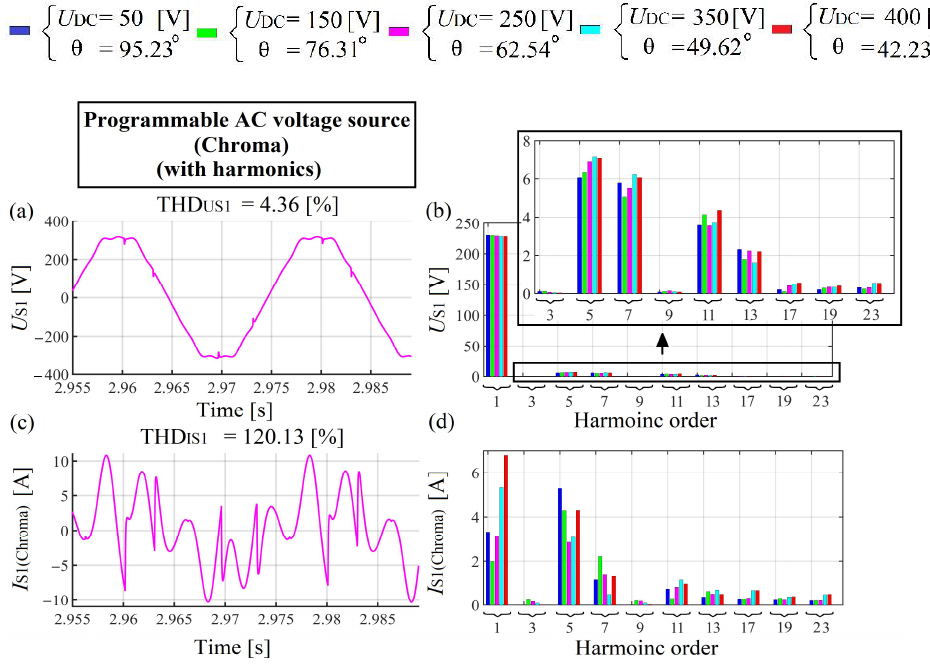
Figure 25. ( a ) PCC voltage waveform with ( b ) its spectrum, ( c ) voltage source input current with ( d ) its spectrum (load and filter connected).